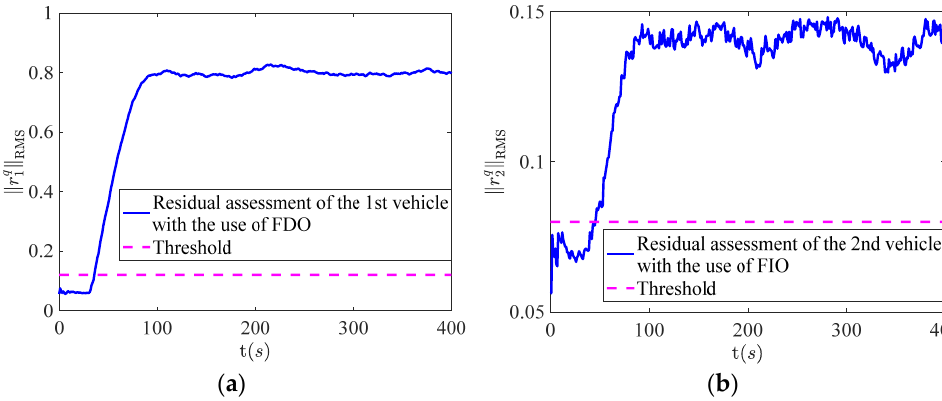
Figure 7. The results of fault isolation, where ( a ) represents the 1st vehicle with the use of FDO; ( b ) represents the 2nd vehicle with the use of FIO.